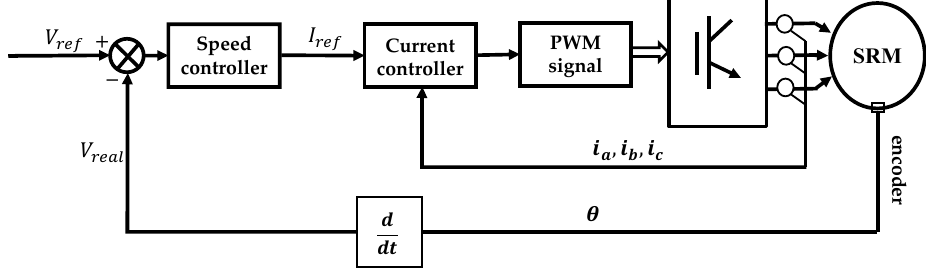
an approximate periodic oscillation trend, with the oscillation period of 30 ◦ . When the turn-off angle is around 138 ◦ , the 12th-order current harmonic and vibration obtain the minimum value.